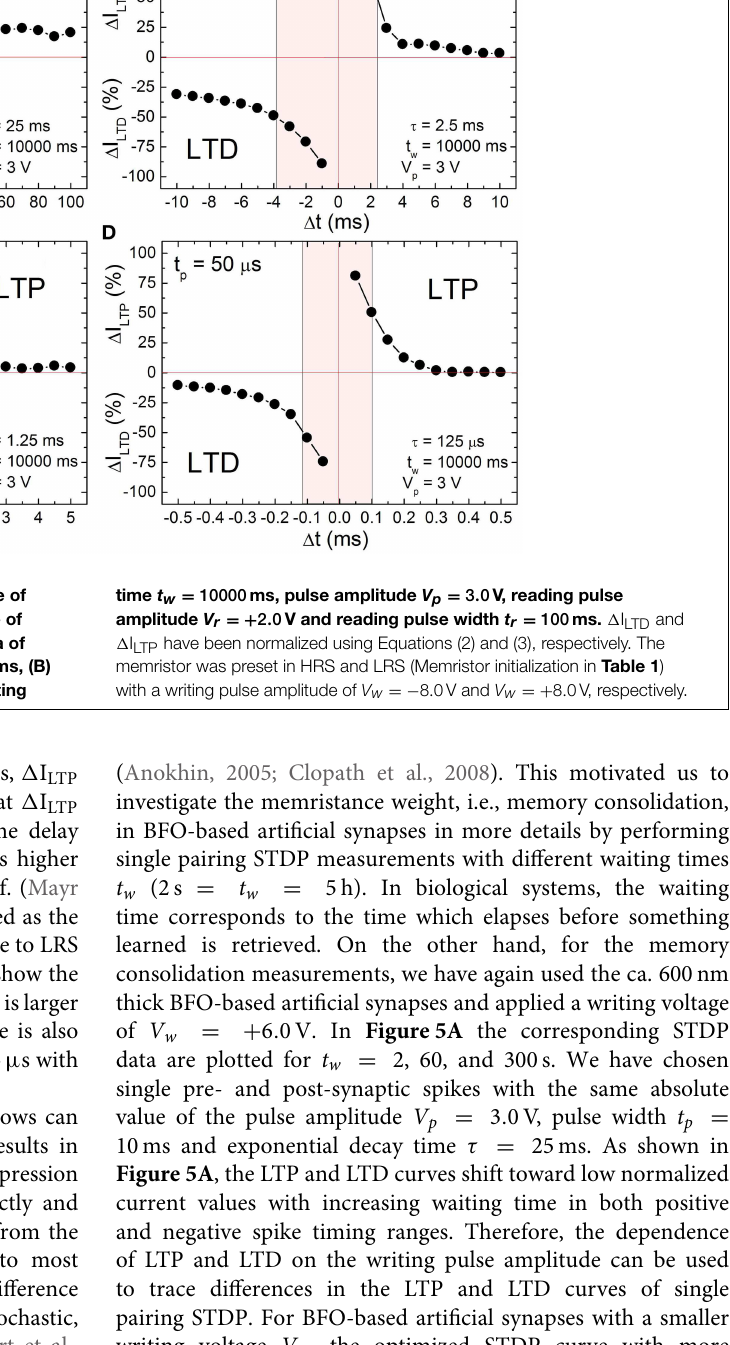
time t w = 10000 ms, pulse amplitude V p = 3 . 0 V, reading pulse amplitude V r = + 2 . 0 V and reading pulse width t r = 100 ms. 1 I LTD and 1 I LTP have been normalized using Equations (2) and (3), respectively. The memristor was preset in HRS and LRS (Memristor initialization in Table 1 ) with a writing pulse amplitude of V w = − 8 . 0 V and V w = + 8 . 0 V,